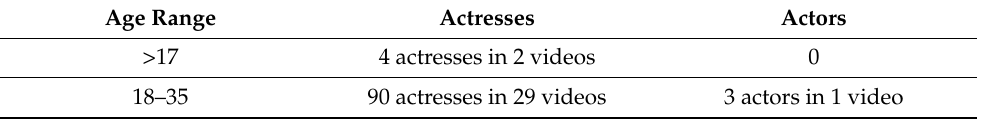
Table 3. Number of actresses and actors and videos in which they appear grouped by